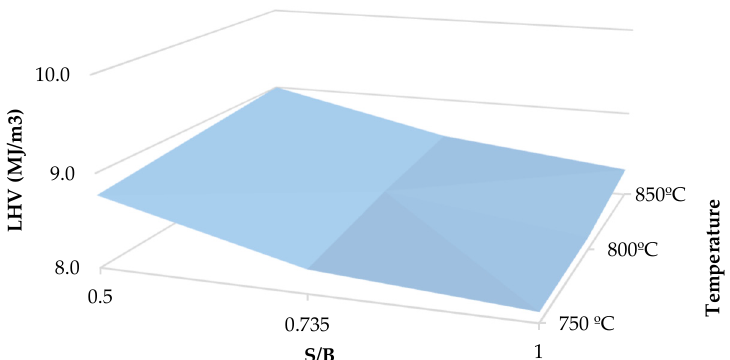
Figure 8. Effect of the steam-to-biomass ratio and temperature on the LHV of the produced gas.